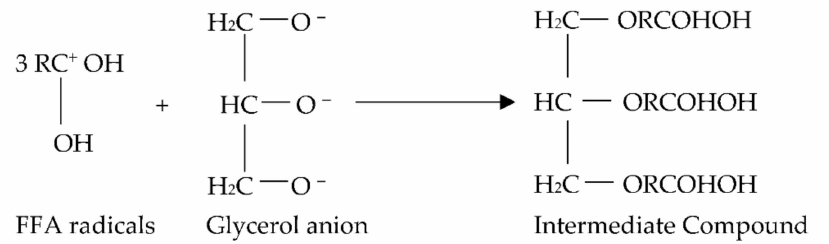
Figure 6. A schematic representation of the glycerolysis reaction third step.